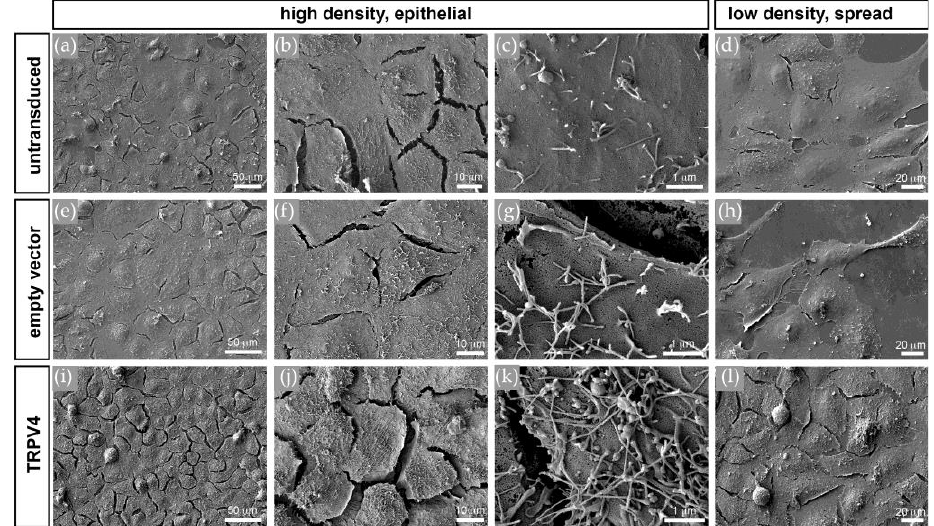
Figure 7. Scanning electron microscopy (SEM). Apical surfaces of confluent non-transduced ( a – d ), empty vector-transduced ( e – h ), and TRPV4-transduced ( i – l ) HCEC-12 cells at increasing magnifi- cations from left to right. Note the differences in number and length of apical membrane protrusions, which is also apparent on the surfaces of less confluent or single cells ( d , h , l ).